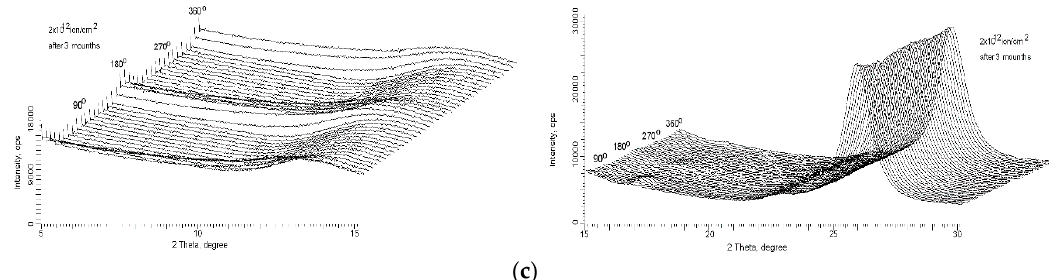
Figure 1. X-ray diffractograms of the polyethylene terephthalate (PET) sample: ( a ) pristine (X-ray diffractograms for the pristine sample were taken from [20] for comparison); ( b ) after irradiation with a dose of 2 × 10 12 ions/cm 2 in the geometry of φ = 0–2 π ; ( c ) temporal evolution of the diffraction spectra of the irradiated PET sample.